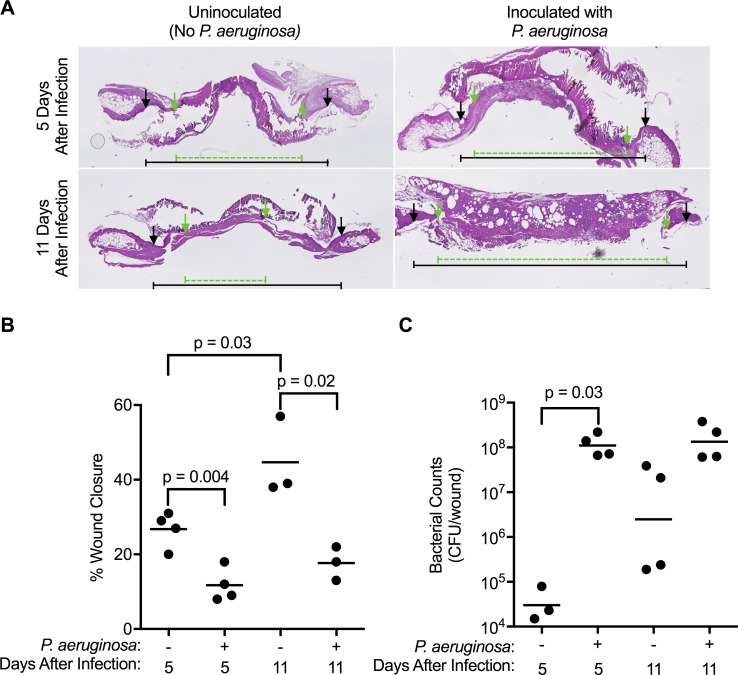
Wound infections initiated with P. aeruginosa liquid cultures delay wound healing.A. H&E staining of excised wounds show original wound edges (black arrows) and the extent of epithelial migration after 5 or 11 days of healing (green arrows). B. The extent of wound closure (healing) was delayed in wounds challenged with P. aeruginosa. C. Total CFU recovered from wounds shows P. aeruginosa-challenged wounds contained high bacterial densities, and unchallenged wounds harbored low densities of bacteria (likely due to spontaneous infection Staphlococcus sp. as previously observed [52]). For A and B, each point represents data from an individual mouse. Significance determined by Mann-Whitney analysis.